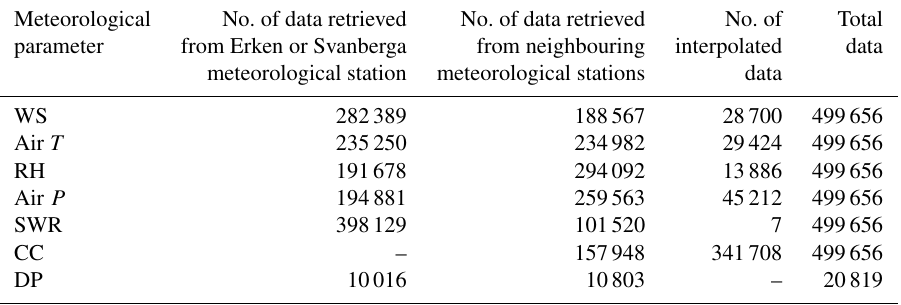
Table 1. Number of data points retrieved from difference sources of the driving meteorological parameters for GOTM simulation. Meteorological No. of data retrieved No. of data retrieved No. of Total parameter from Erken or Svanberga from neighbouring interpolated data meteorological station meteorological stations data WS 282389 188567 28700 499656 Air T 235250 234982 29424 499656 RH 191678 294092 13886 499656 Air P 194881 259563 SWR CC – 157948 341708 DP 10016 10803 –